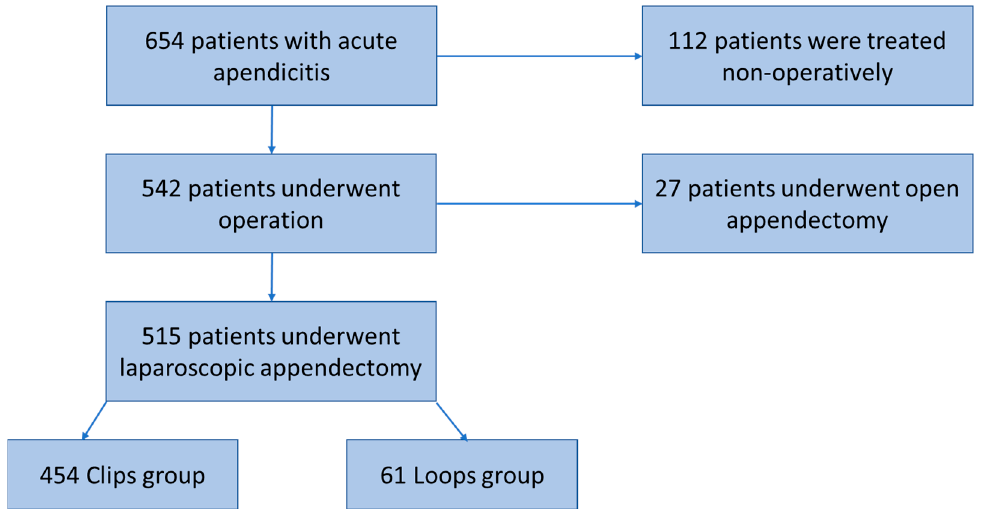
Figure 1. Flowchart of patients’ selection.